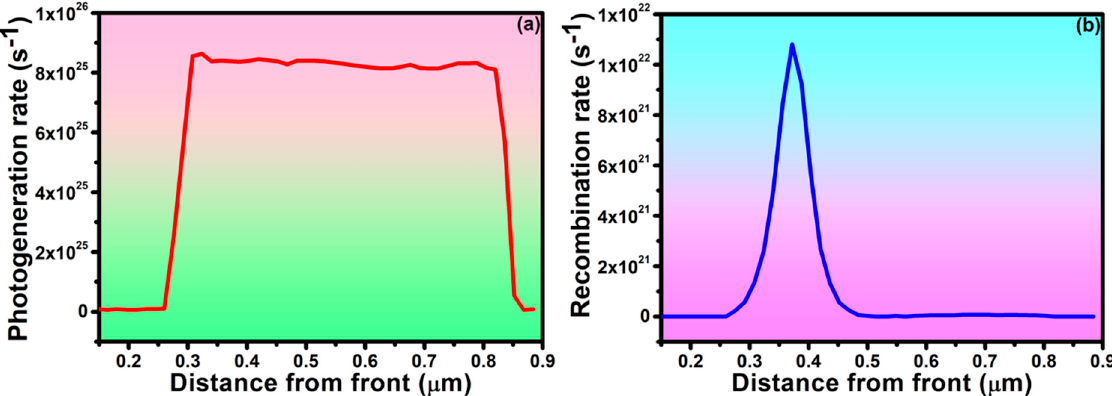
Figure 6. Analysis of ( a ) photogeneration and ( b ) recombination rate of the InGaN solar